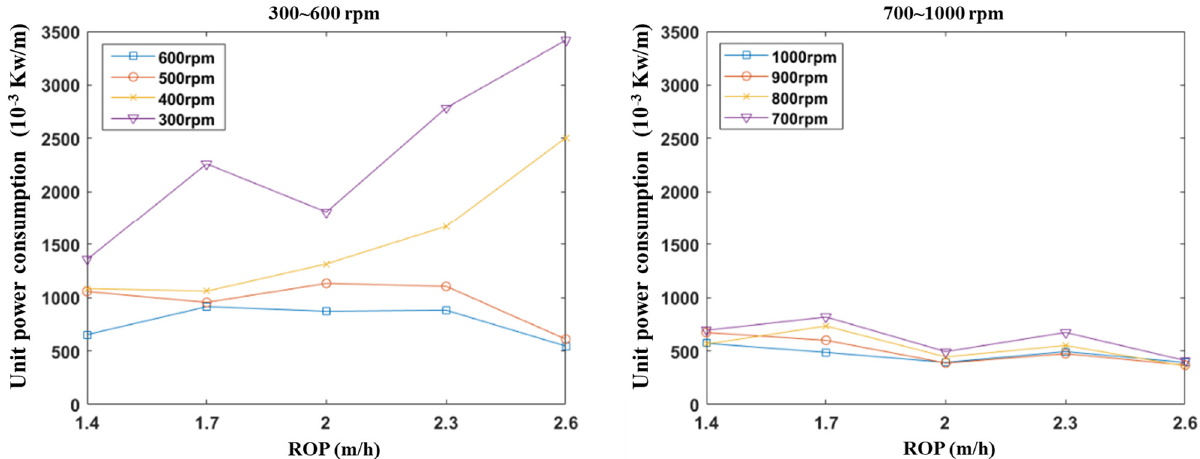
Figure 15. Chart of energy consumption per footage at different